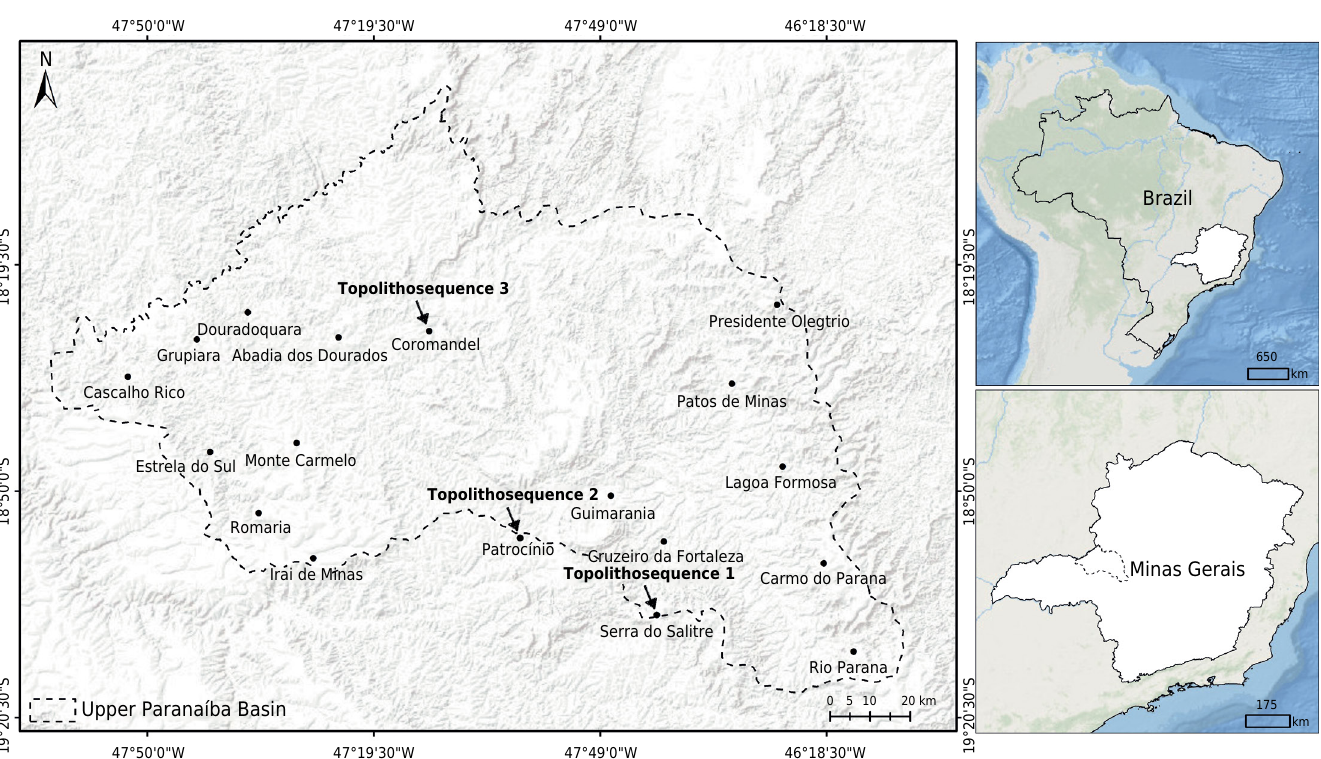
Figure 1. Location of the studied topolithosequences in the Upper Paranaíba